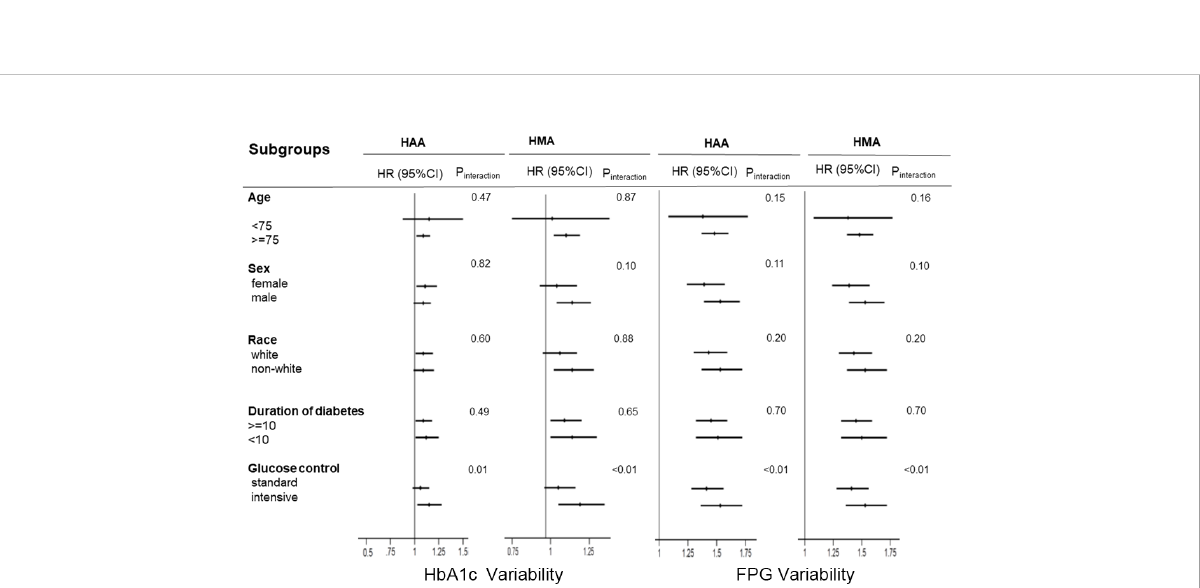
FIGURE 3 Hazard ratios per one standard deviation increase in the HbA1c/FPG variability for the prede fi ned endpoints. Each strati fi cation was adjusted for all factors in model 2 (fasting plasma glucose, plasma glucose control strategy, age, race, female, history of cardiovascular disease, education, depression, cigarette, duration of diabetes, alcohol, body mass index, low-density lipoprotein, high-density lipoprotein, glomerular fi ltration rate, HbA1c), except for the strati fi cation factor itself. HAA, hypoglycemia requiring any third-party assistance; HMA, hypoglycemia requiring medical assistance; HbA1c, Hemoglobin A1c; FPG, Fasting plasma